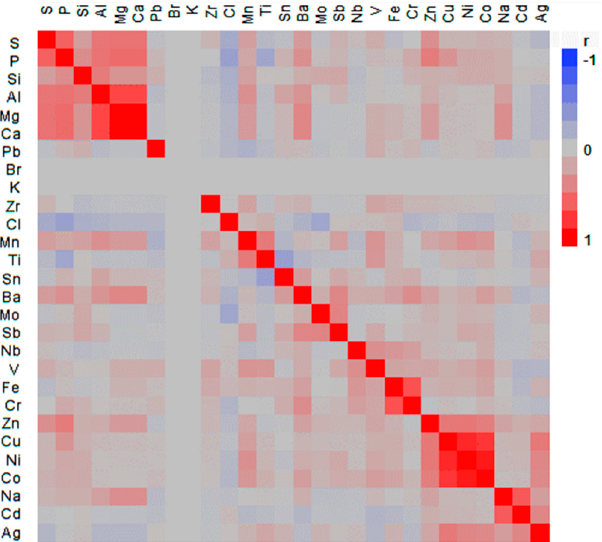
Figure 1. Clustered correlation analysis of elemental analysis present in olive oils and other seed oils. Common earth elements; sulfur, phosphorous, silicon, aluminum, magnesium and calcium show a positive correlation with each other. Similarly, heavy metals, including iron, copper, zinc, chromium, nickel and cobalt, tend to show a positive correlation with each other.